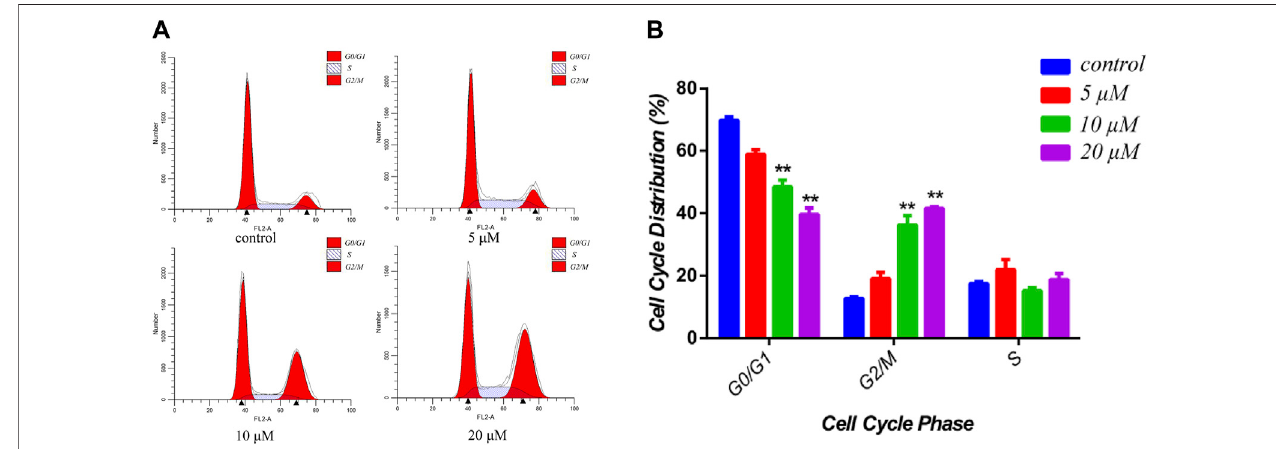
FIGURE 8 | Effects of siragrosvenin D on cell cycle distribution in MCF-7 cells. (A) MCF-7 cells were treated by siragrosvenin D (0, 5, 10, and 20 μ M) for 24 h and then analyzed by fl ow cytometry for cell cycle distribution. (B) Data were presented as the mean ± SD of three independent experiments. ** p < 0.01 vs. control was considered statistically signi fi cant.